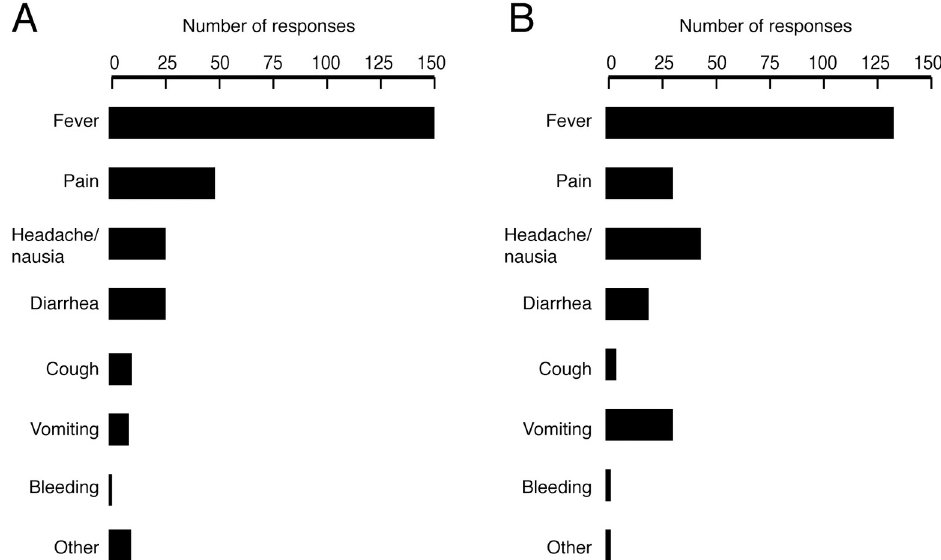
Fig 5. Reported clinical signs and symptoms initiating health seeking behavior. Panel A: health issue that would initiate health seeking behavior by the individual. Panel B: health issue that would prompt community to seek care for